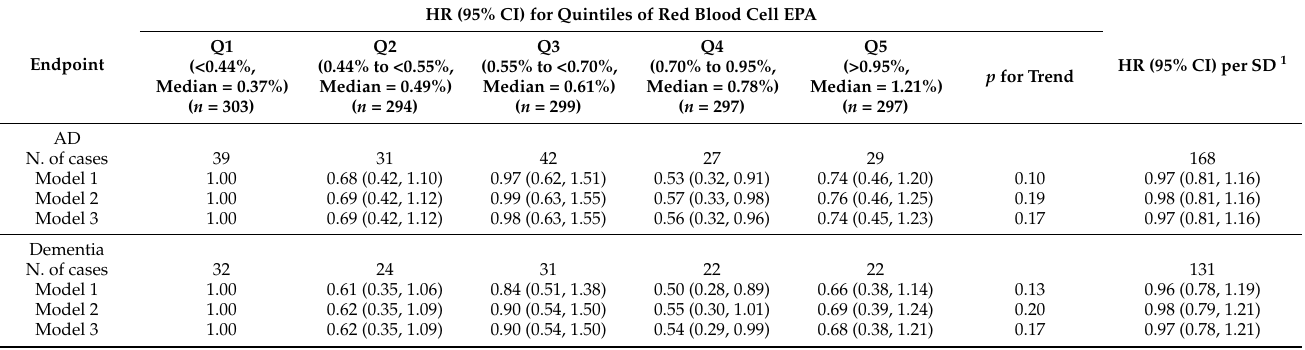
Table 4. Hazard ratios (HR) for red blood cell EPA on Alzheimer’s disease (AD) and all-cause dementia ( n = 1490).